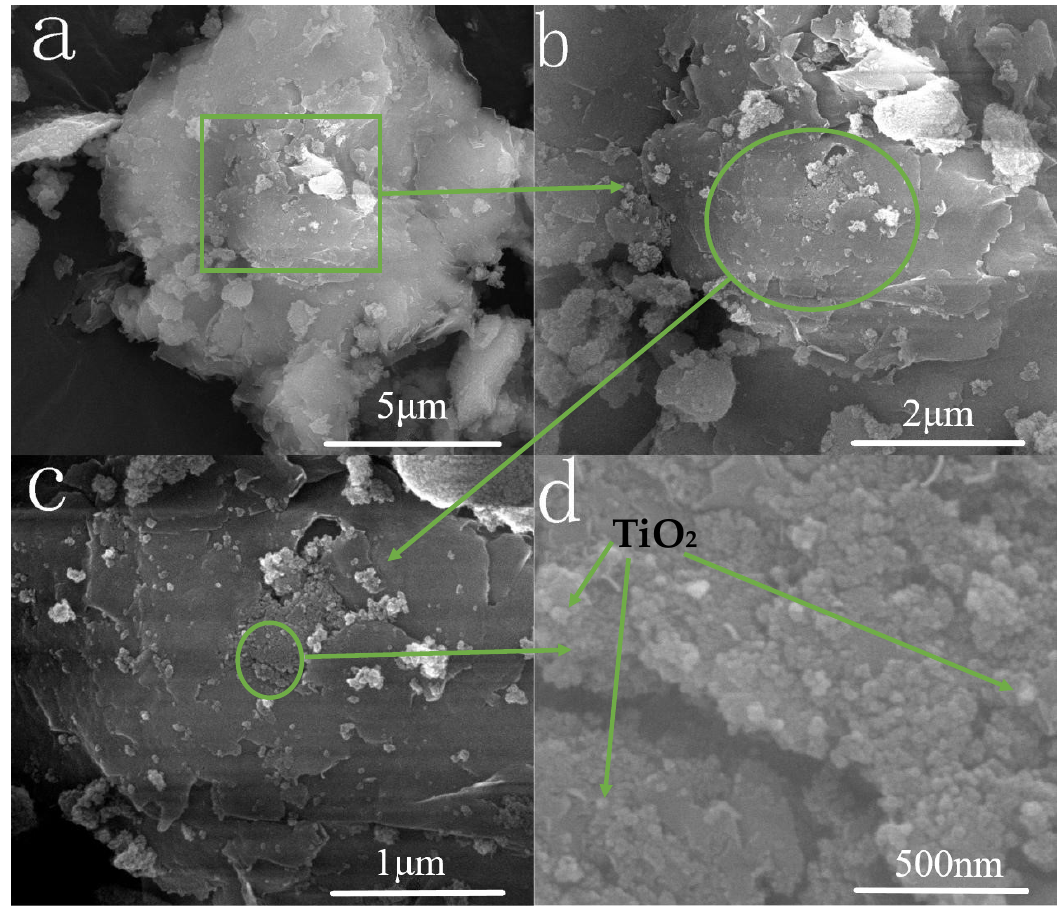
Figure 3. ( a – d ) Scanning electron microscopy images of 30%-TM at different magnifications.